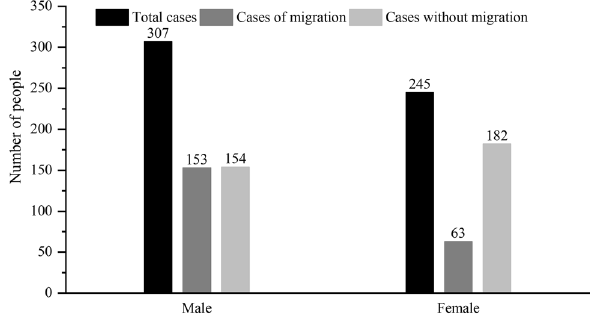
Figure 2. Gender characteristics of confirmed COVID-19 cases in Shandong province.